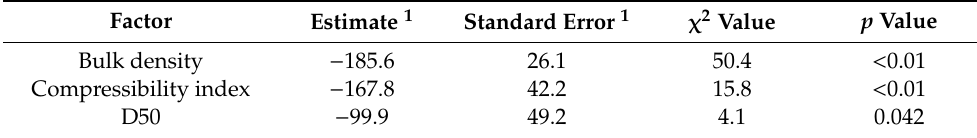
Table 4. Crucial powder properties a ff ecting % retention of DT estimated using the ENET technique. Factor